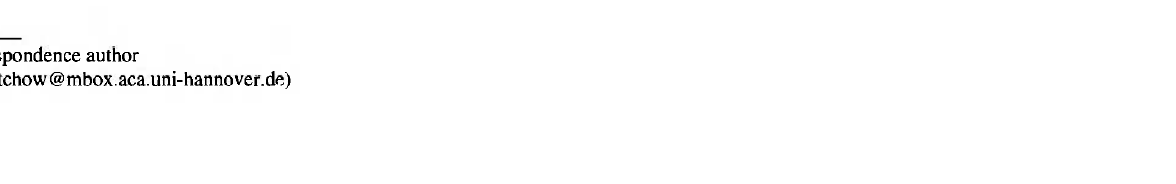
CoCrGe, hexagonal, P^mmc (No. 194), a = 4.092(1) Ä, c = 5.145(2) Ä, V= 74.6 Ä 3 , Z= 2, R e (F) = 0.049, wR m (F 2 ) = 0.097, Γ= 300